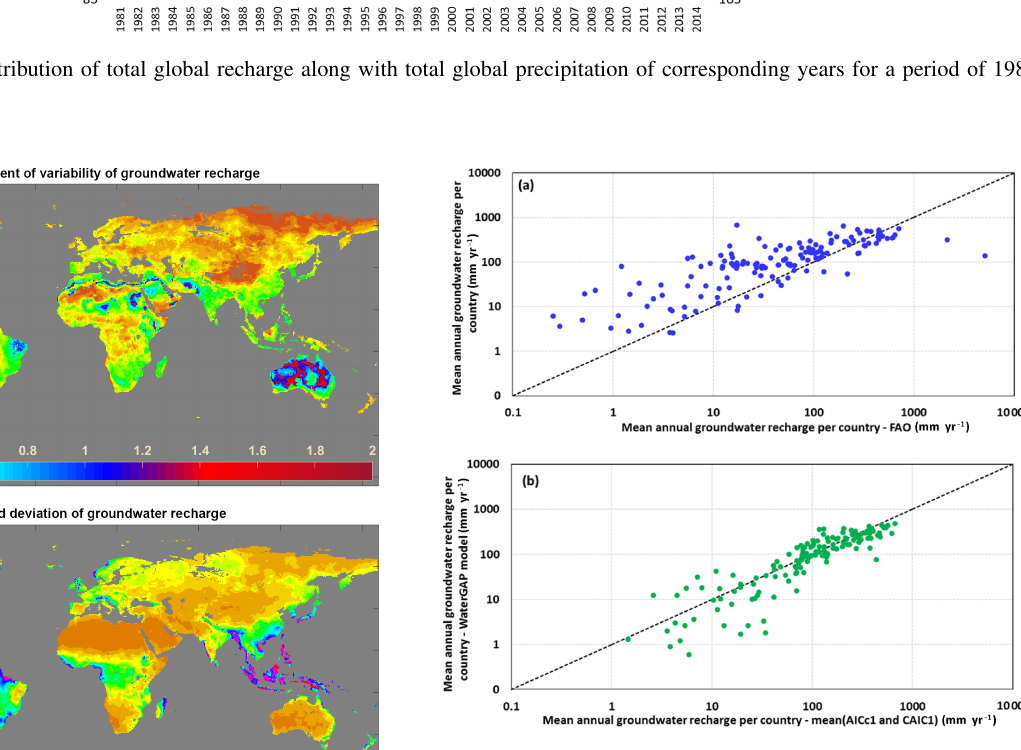
Figure 11. Comparison of predicted recharge against country-level estimates from (a) FAO and (b) WaterGAP